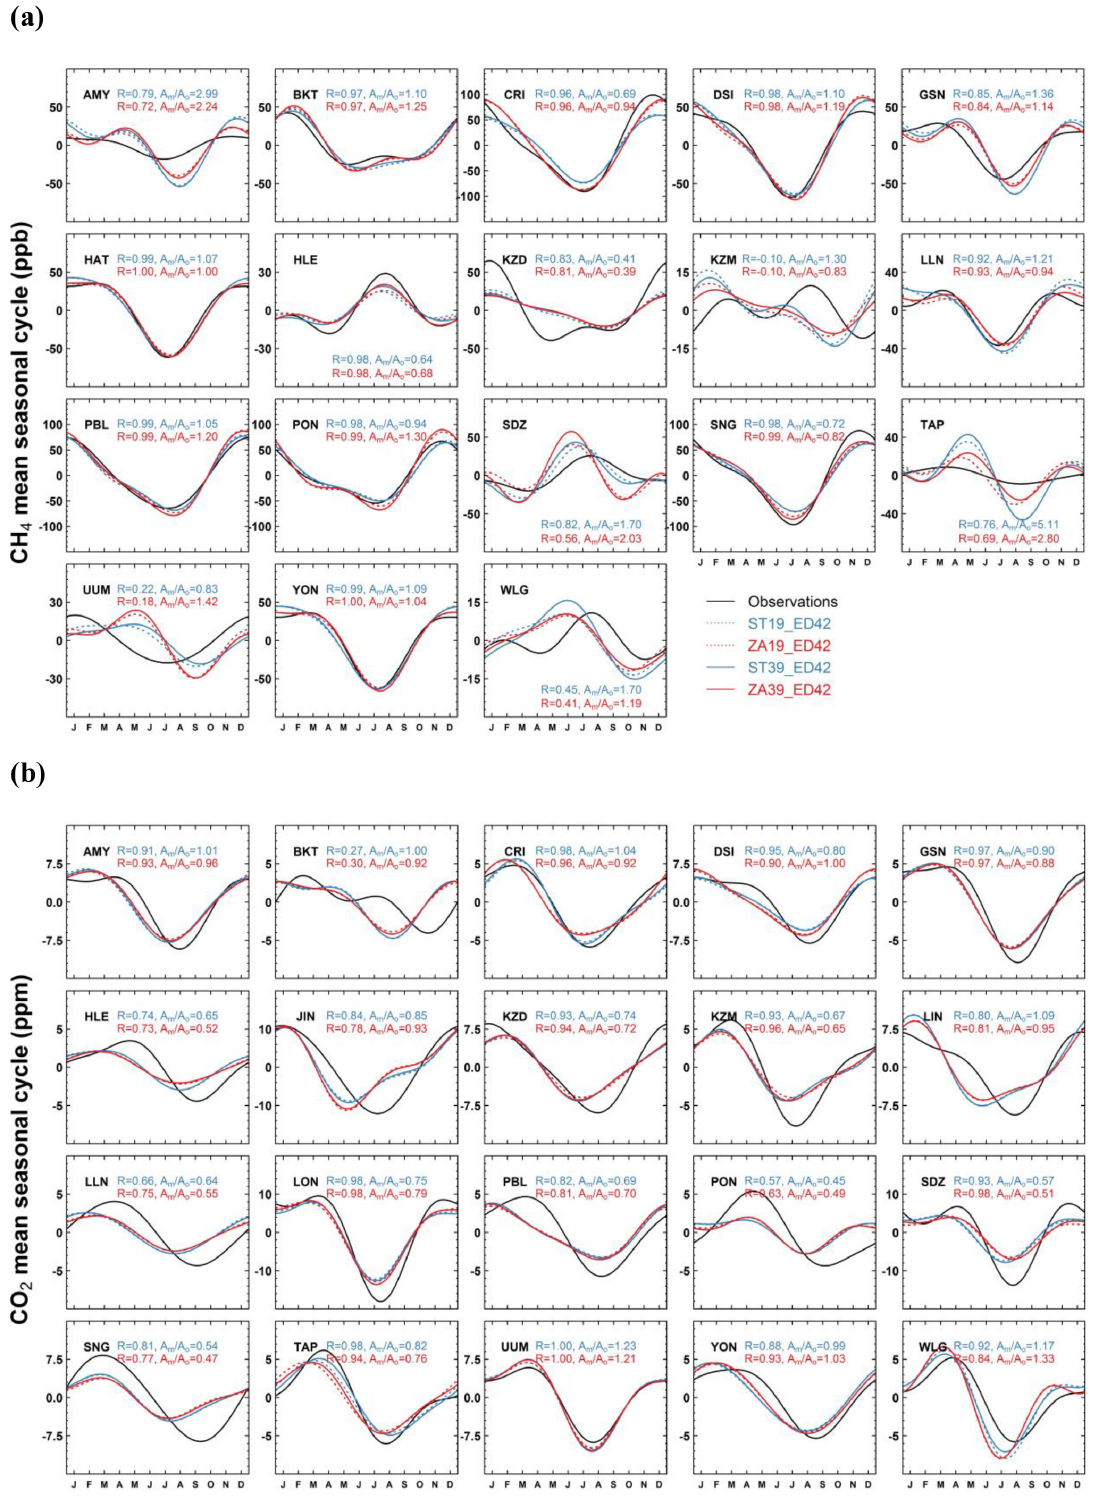
Figure 3. The observed and simulated mean seasonal cycles of CH 4 (a) and CO 2 (b) for stations within the zoomed region. In each panel, the simulated mean seasonal cycles are based on model outputs from STs (blue lines) and ZAs (red lines), respectively. The text shows statistics between the simulated and observed seasonal cycles for 39-layer